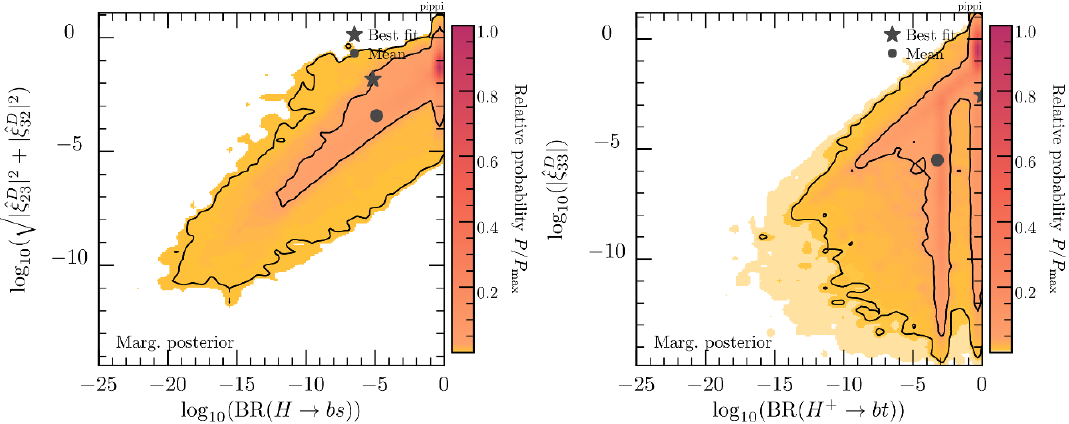
Figure 13 . Left : log log(BR( H + ! tb